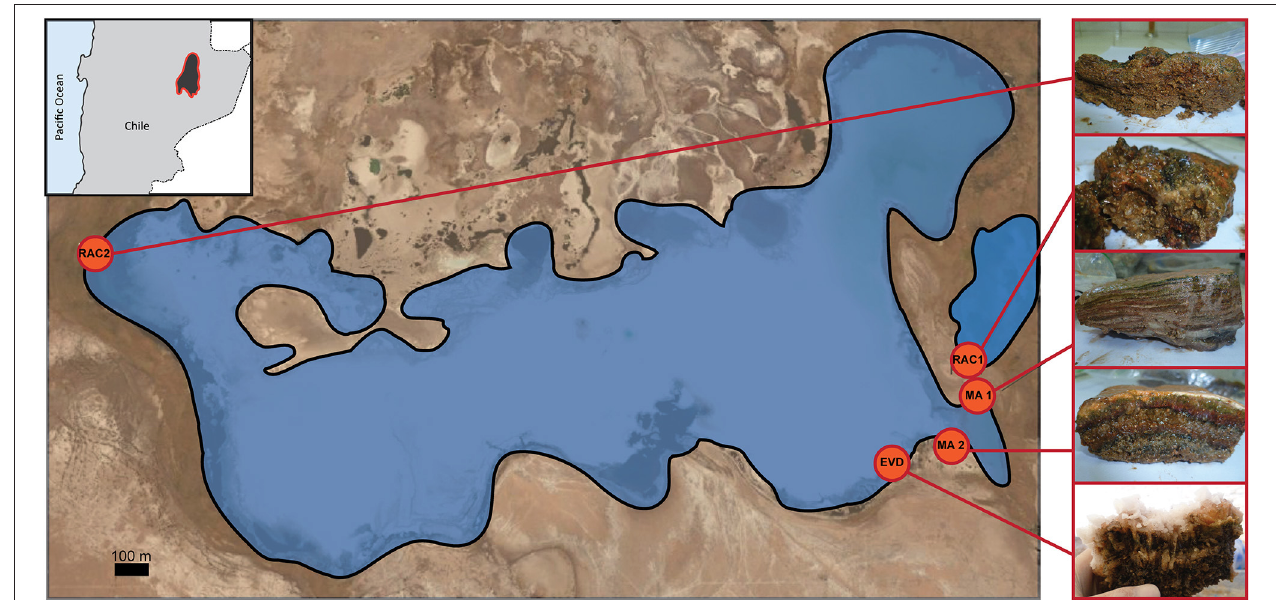
FIGURE 1 | Location of microbial mats (MA1 and MA2), rhizome-associated lithified concretions (RAC1 and RAC2), and evaporite (EVD) in Laguna Tebenquiche.